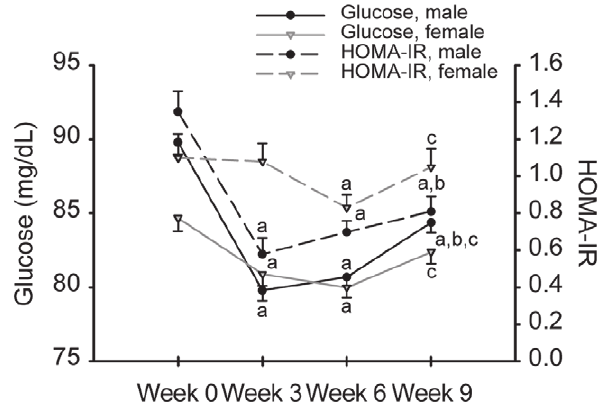
Figure 2. Effect of basic combat training on blood glucose and HOMA-IR. All values are mean 6 SEM; n=100M, 71F. Two-factor mixed model repeated measures ANOVA. Sex-by-time interaction observed for all biomarkers, P , 0.05. Different from a week 0, b week 3, c week 6, P , 0.05.